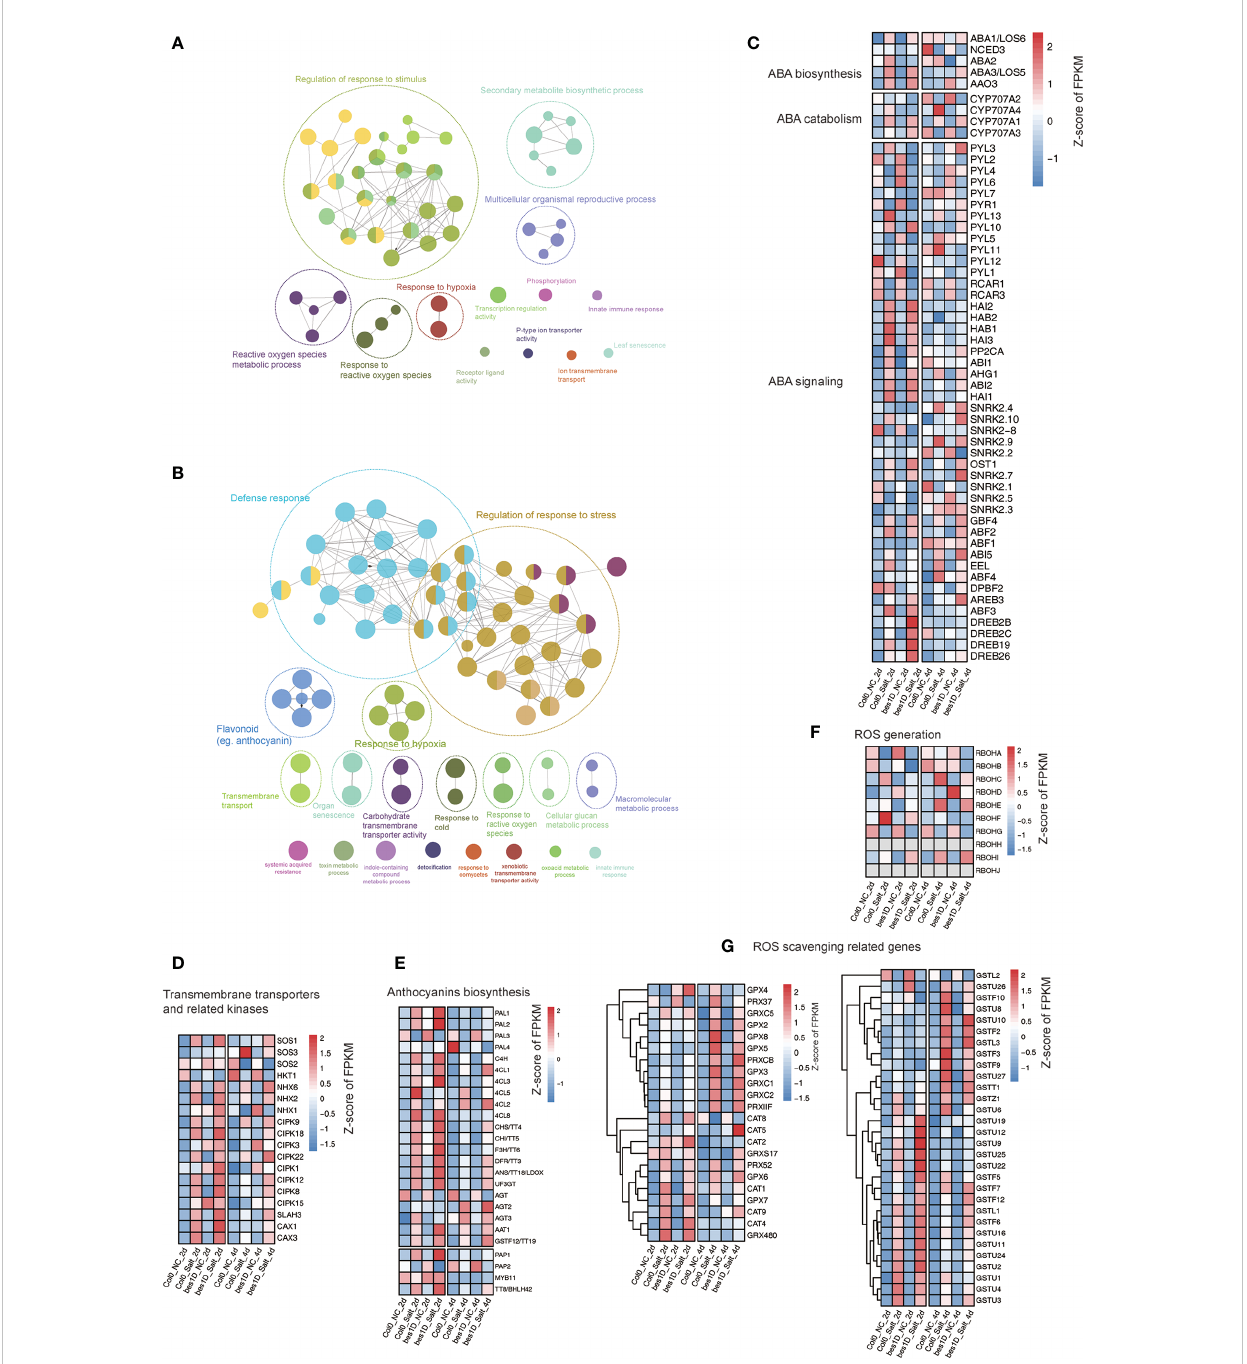
FIGURE 7 Network and pathways analyses of key modules affected in bes1-D . Gene Ontology enrichment network of genes in Cluster 2 (A) and Cluster 3 (B) . Expression pro fi ling of genes evolved in ABA biosynthesis, catabolism, and signaling (C) ; Na + /K + ion transportation (D) ; Anthocyanins biosynthesis (E) ; ROS generation (F) ; and ROS scavenging (G)